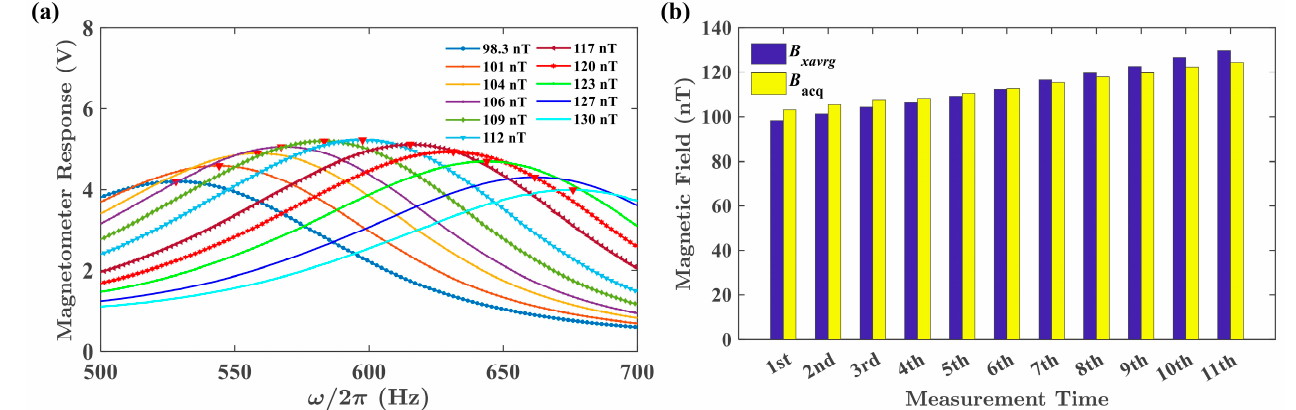
Figure 4. ( a ) Dependence of the magnetometer response on ω /2 π under different magnetic field offsets B xavrg . Resonance frequency peaks are marked with red inverted triangles. ( b ) Comparison between the active applied magnetic field B xavrg and B acq acquired from ( a ). The label of horizontal axis “Measurement Time” represents each measurement with different B xavrg